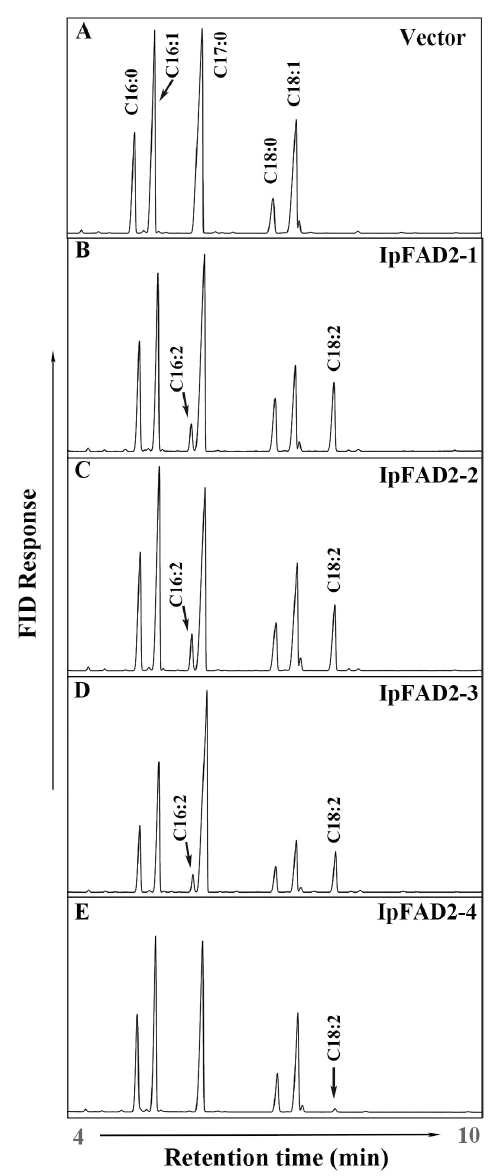
Figure 4. GC analysis of fatty acid methyl esters (FAMEs) isolated from yeast cells expressing IpFAD2s. The FAMEs of total lipid were extracted from yeast transformed with control empty control vector pESC-his ( A ), IpFAD2-1 ( B ), IpFAD2-2 ( C ), IpFAD2-3 ( D ), and IpFAD2-4 ( E ) under induction conditions and analyzed by gas chromatography/flame ionization detector (GC/FID). Major fatty acids peaks are labeled. The newly synthesized fatty acids corresponding to C16:2 Δ9,12 and C18:2 Δ9,12 are indicated by the arrows. Heptadecanoic acid methyl ester (C17:0) is used as the internal standard.